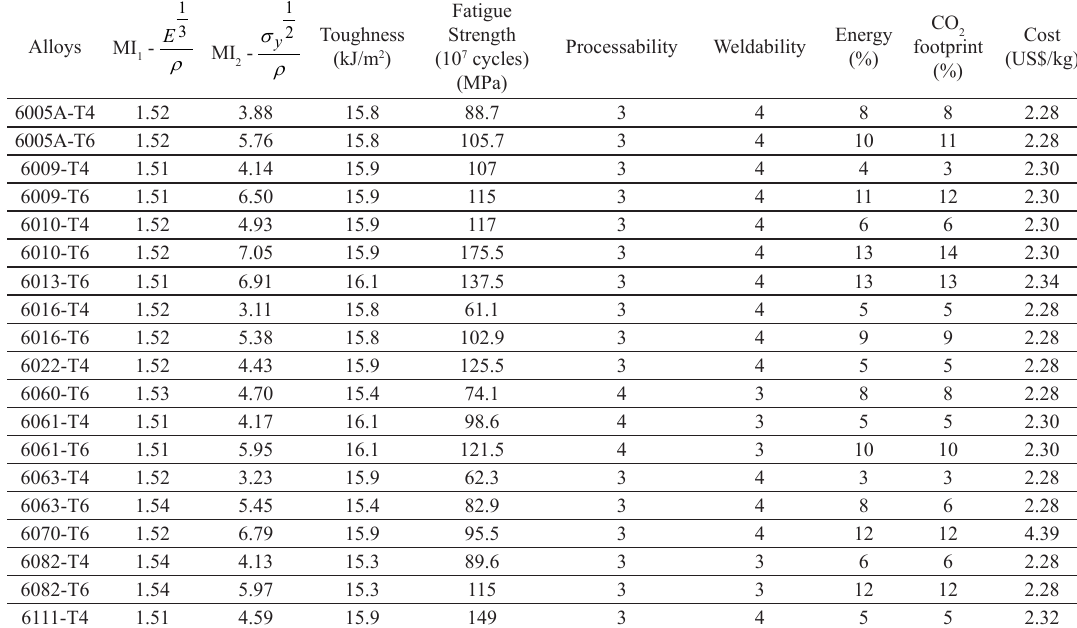
Table 2. Summary of the property values of the 6000 alloys.